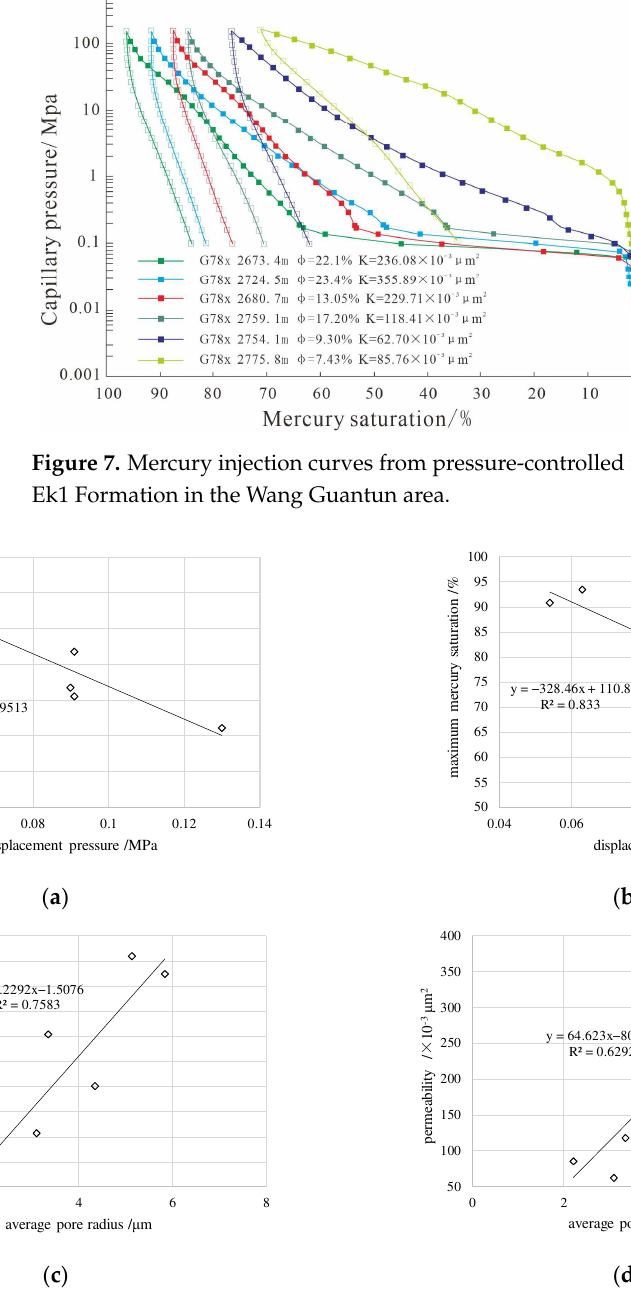
Figure 8. Relationship between parameters of pore structure and porosity, permeability of typical samples of Ek1 member in the Wang Guantun Area. ( a ) displacement pressure and average pore radius, ( b ) displacement pressure and maximum mercury saturation , ( c ) average pore radius and porosity, ( d ) average pore radius and permeability.